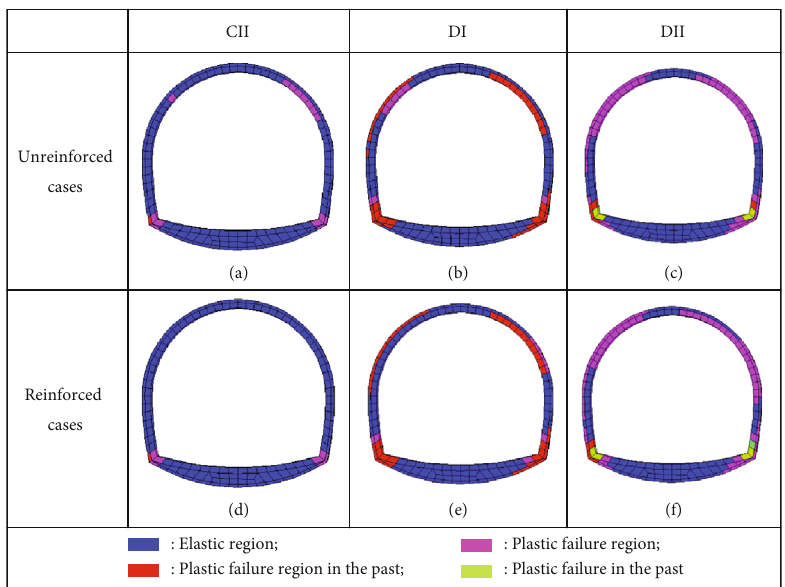
Figure 7: Plastic failure region on lining concrete for tunnel constructed by NATM.